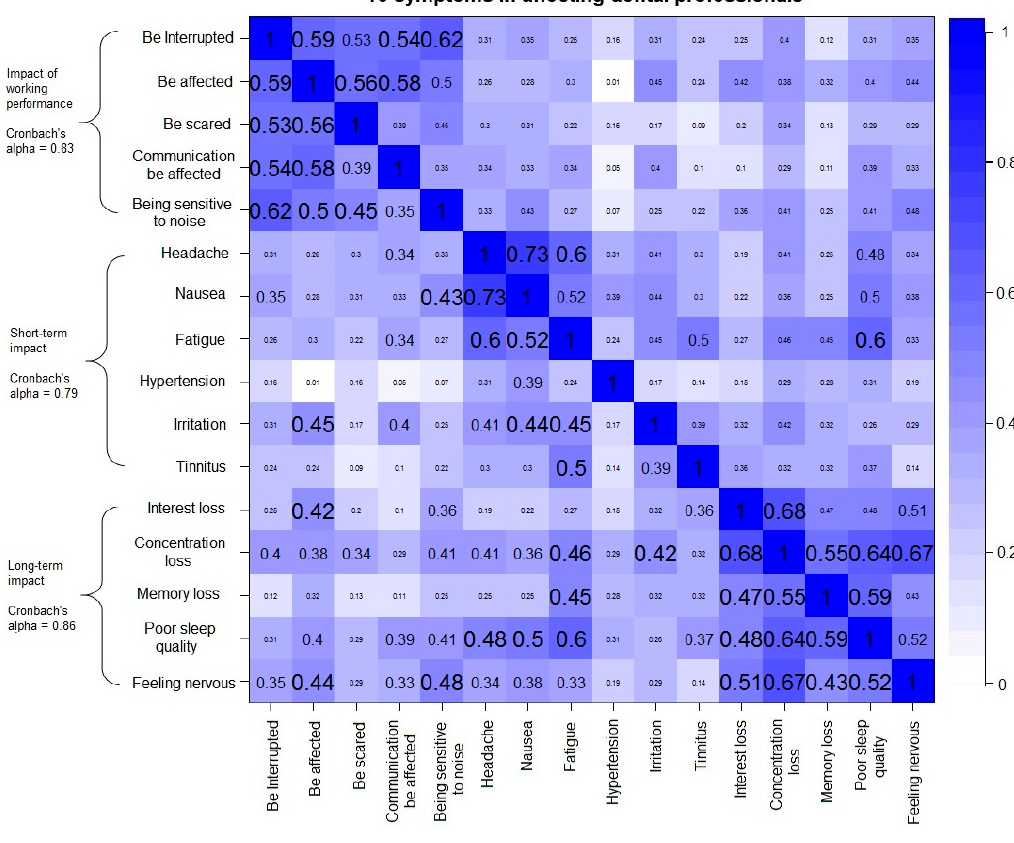
Figure 3. A correlation plot of the 16 symptoms in the negative impact of working performance, short ‐ term impact and long ‐ term impact on the dental professionals from their exposure to the dental